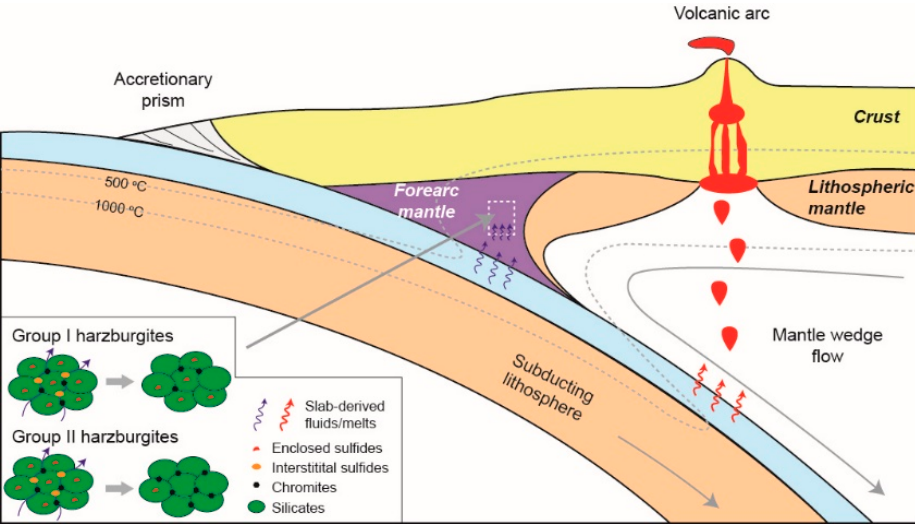
Figure 8. Cartoon for the genesis of two different HSE patterns in forearc mantle. The forearc mantle is both physically and chemically heterogeneous. For the Group-I patterns, interstitial sulfides in the mantle were significantly removed, whereas the sulfides included within silicates remained mainly untouched. Pt-bearing alloys were also generated to produce Pt enrichment over Pd. The Group-II patterns were produced in forearc mantle in which almost all sulfides were stripped. Breakdown of sulfides released all HSEs to the hydrous magmas, and Ru was trapped within the chromite. Combined with HSE compositions of mantle wedge xenoliths [12,13], our data support that subduction can result in strong fractionation in HSEs of the subarc mantle at different depths.